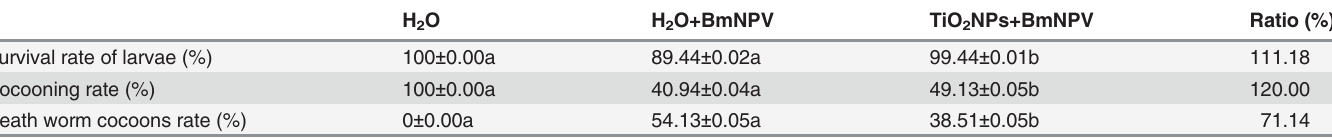
Table 2. Effect of TiO 2 NPs on larval survival and cocooning after BmNPV infection.